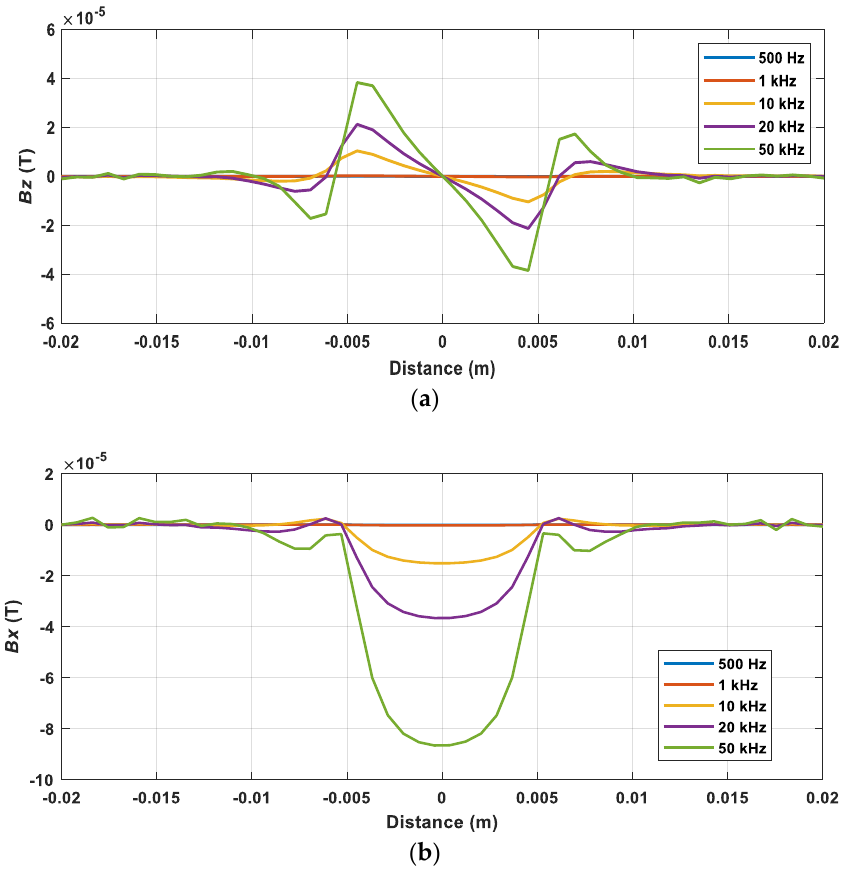
Figure 3. The magnetic B field received by the sensing probe under different excitation frequencies ( a ) 𝑩 𝑧 , ( b ) 𝑩 𝑥 . ( a ) B z , ( b ) B x